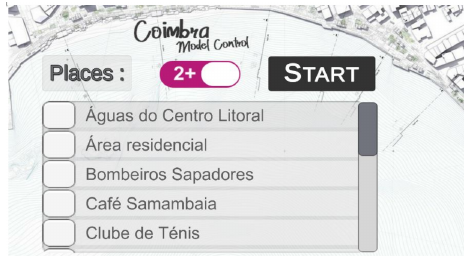
Figure 8. Mobile user interface, to control PARIMC from a cell phone or other device. Figure 9 details the process of communication between the mobile interface and the control unit.